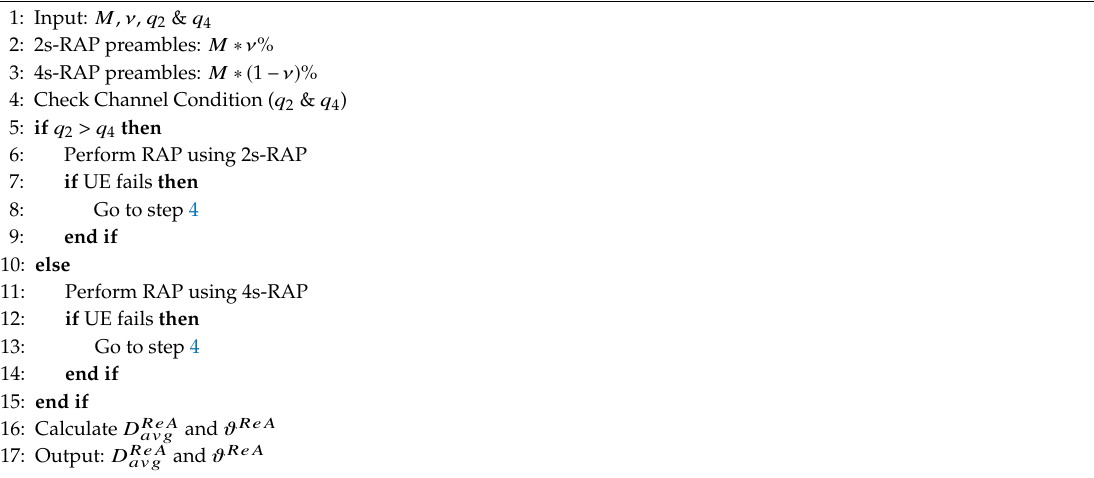
Algorithm 1 2s-RAP and 4s-RAP using reasserting algorithm